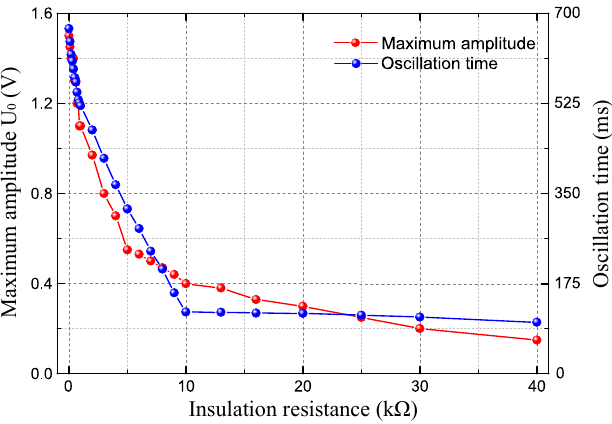
Figure 12. Zero-sequence voltage change .